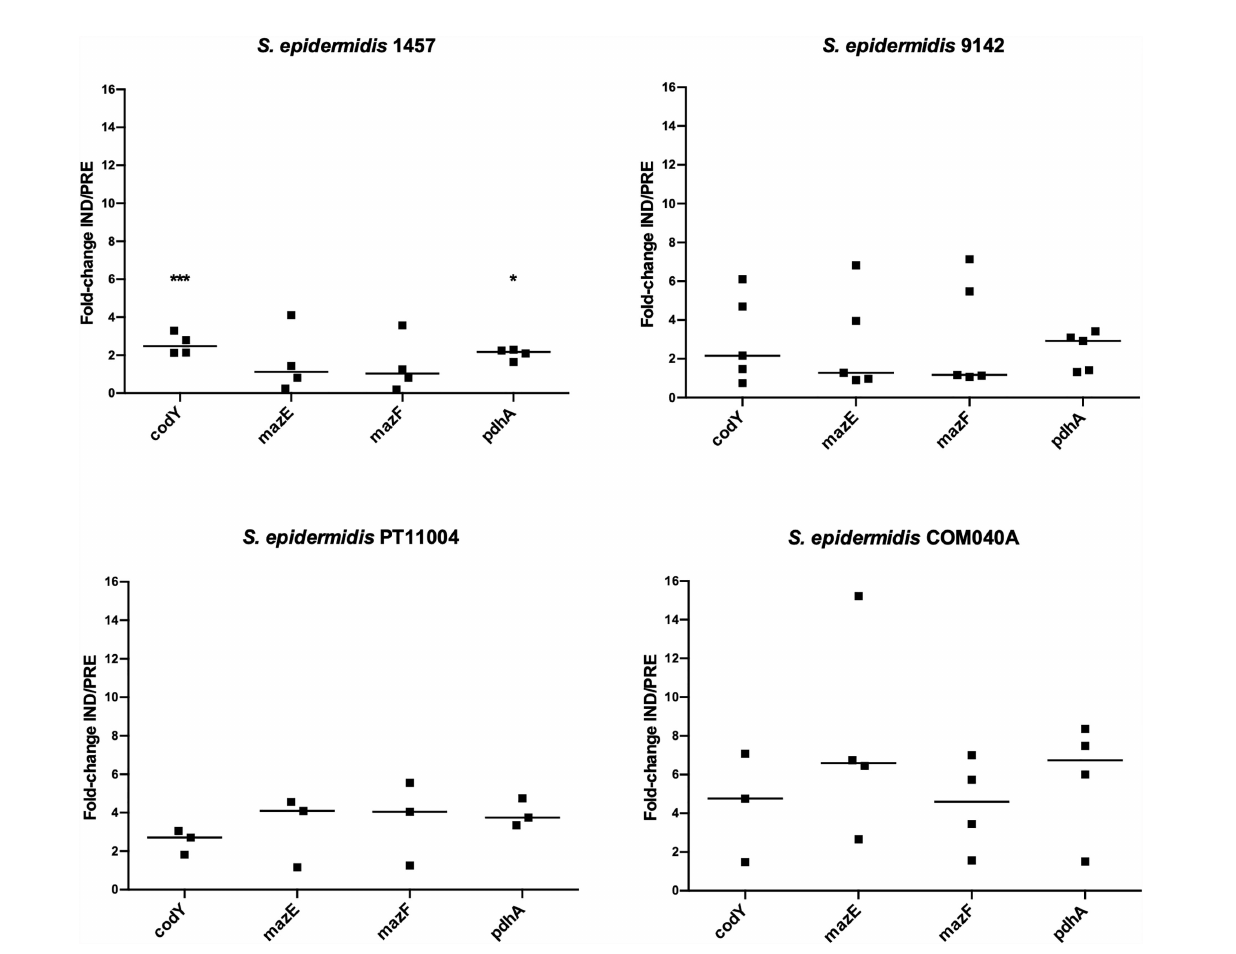
FIGURE 2 | Expression of the genes of interest in 48 h-old bio fi lms populations of S. epidermidis 1457 grown under induced (IND) and prevented (PRE) VBNC conditions. Data is presented as the fold-change between the IND and the PRE VBNC conditions (IND/PRE). Data is represented as the fold-change of the individual assays, where the horizontal lines represent the median of at least three independent experiments. * p < 0.05, *** p < 0.001 (Unpaired Welch ’ s